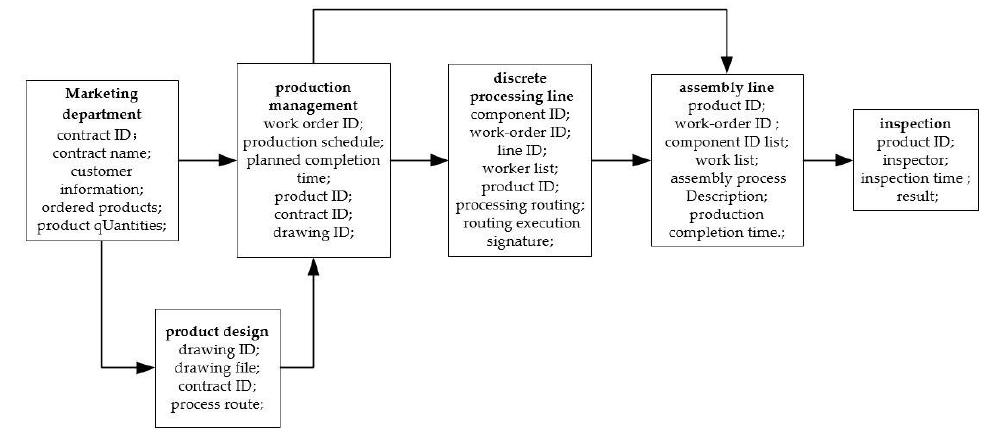
Figure 3. Metadata of each entity and its data flow.